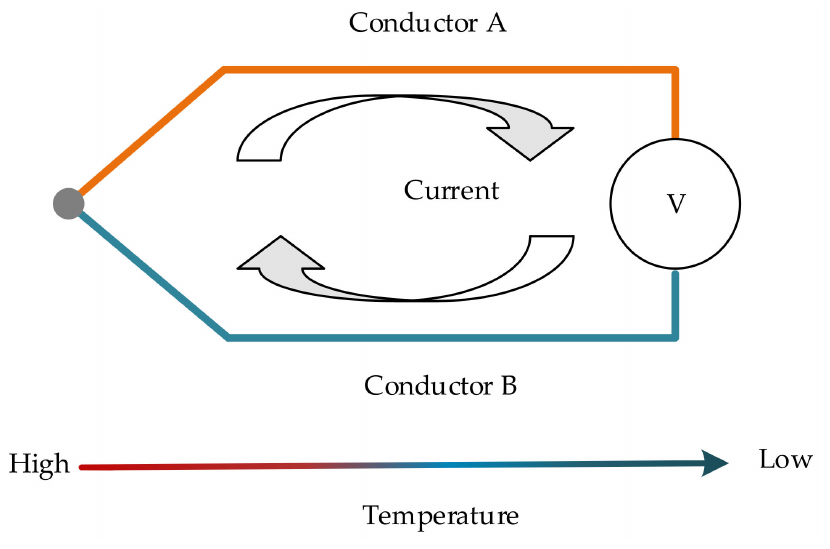
Figure 1. Diagram of the Seebeck